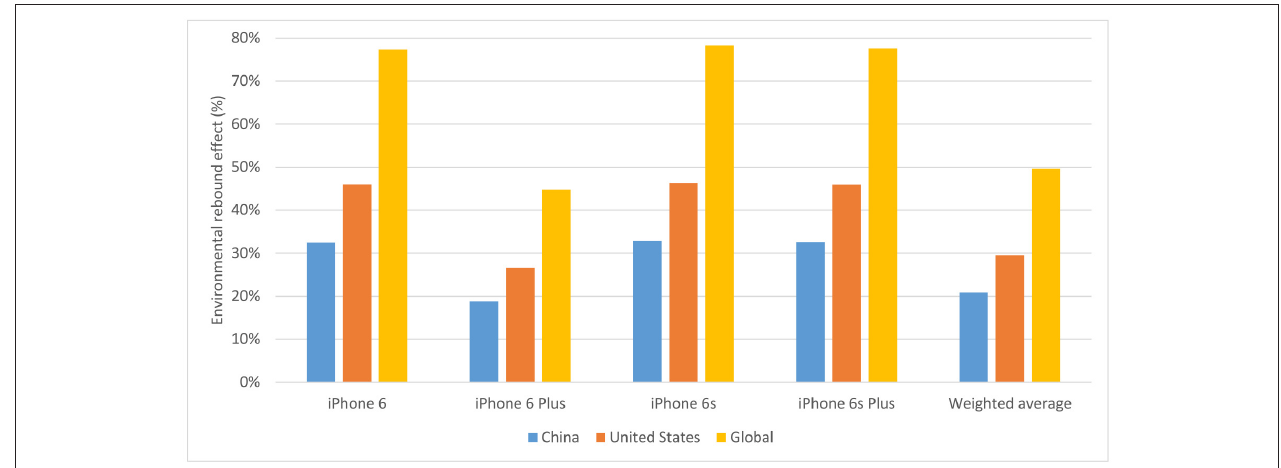
FIGURE 2 | Environmental rebound effect (ERE) magnitude of reusing a smartphone for selected iPhone models and economies with imperfect substitution. The “average” model corresponds to a weighted average of all four iPhone models by their eBay sales volume. The ERE is expressed as the % of avoided GHG emission that are offset due to re-spending.